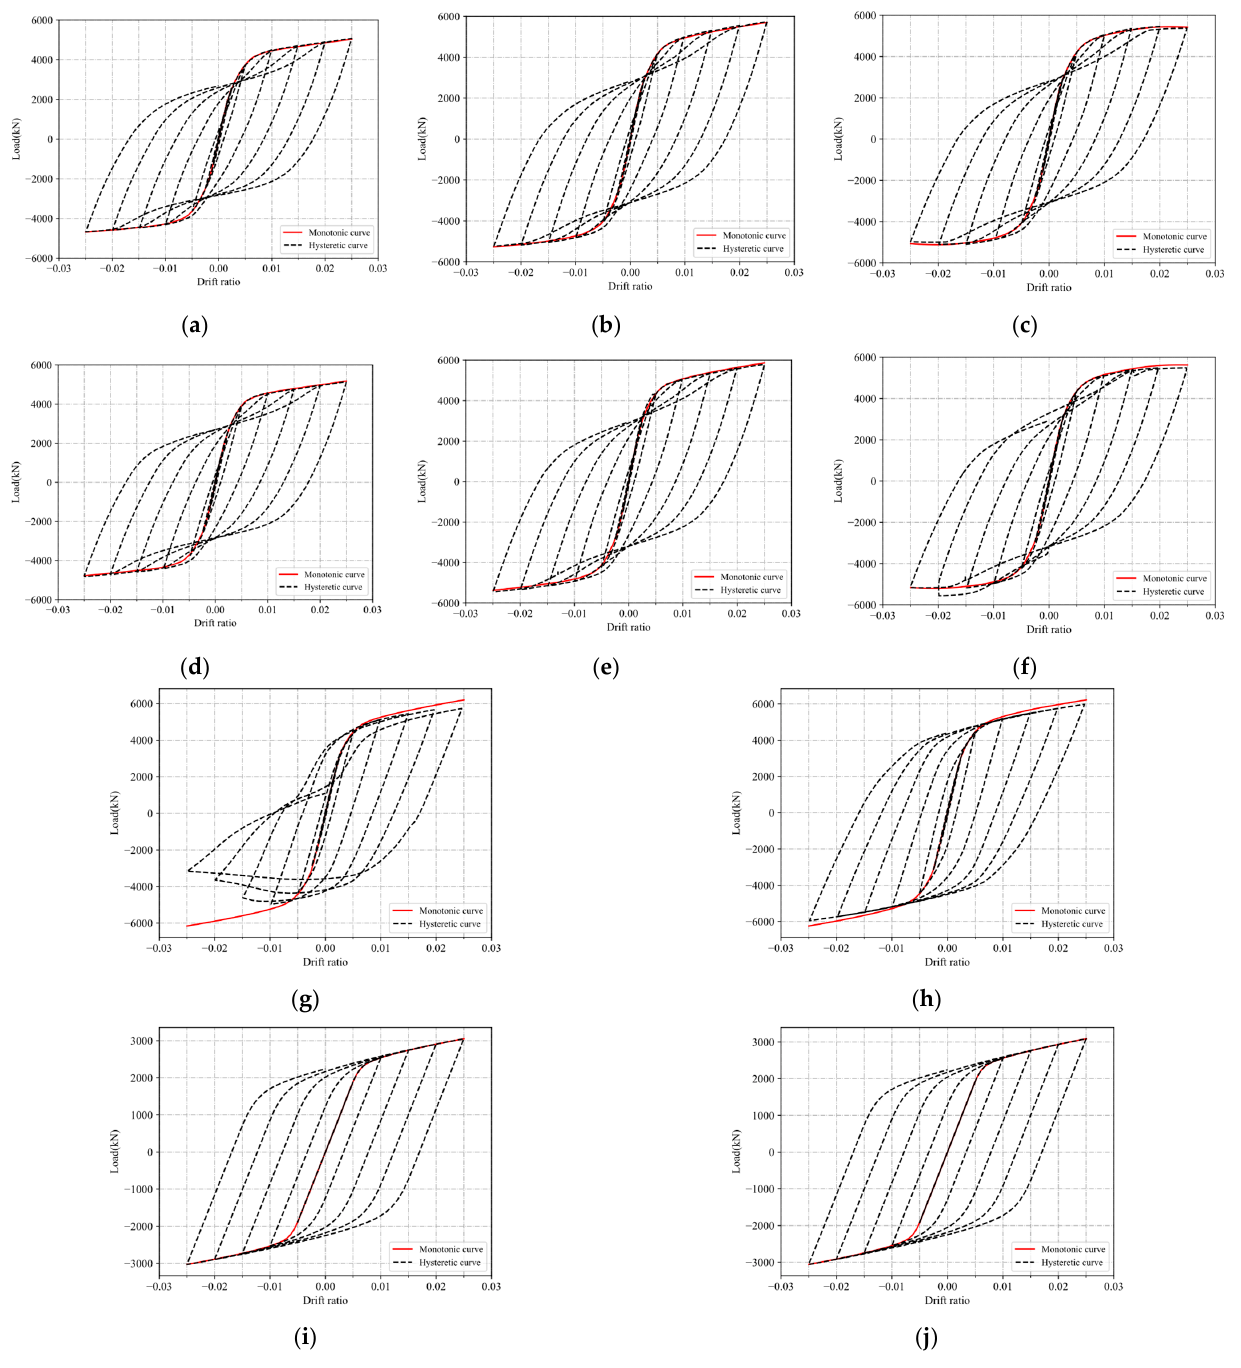
Figure 12. Comparison between hysteretic curves and pushover curves of SPSWs with different numbers of bolts, SPSWs with two-side fi xed connections and frames: ( a ) SPSW-N8; ( b ) SPSW-N14; ( c ) SPSW-N20; ( d ) SPSW-N8-X; ( e ) SPSW-N14-X; ( f ) SPSW-N20-X; ( g ) SPSW-T; ( h ) SPSW-T-X; ( i ) FRAME; ( j ) FRAME-X.